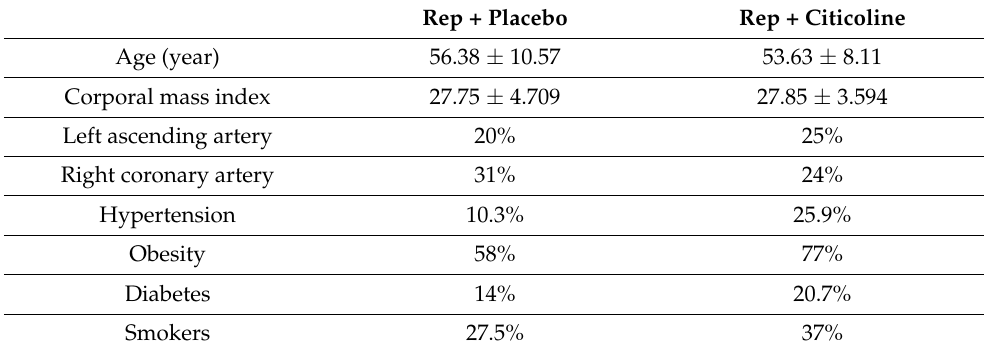
Table 1. Patient characteristics and risk factors.